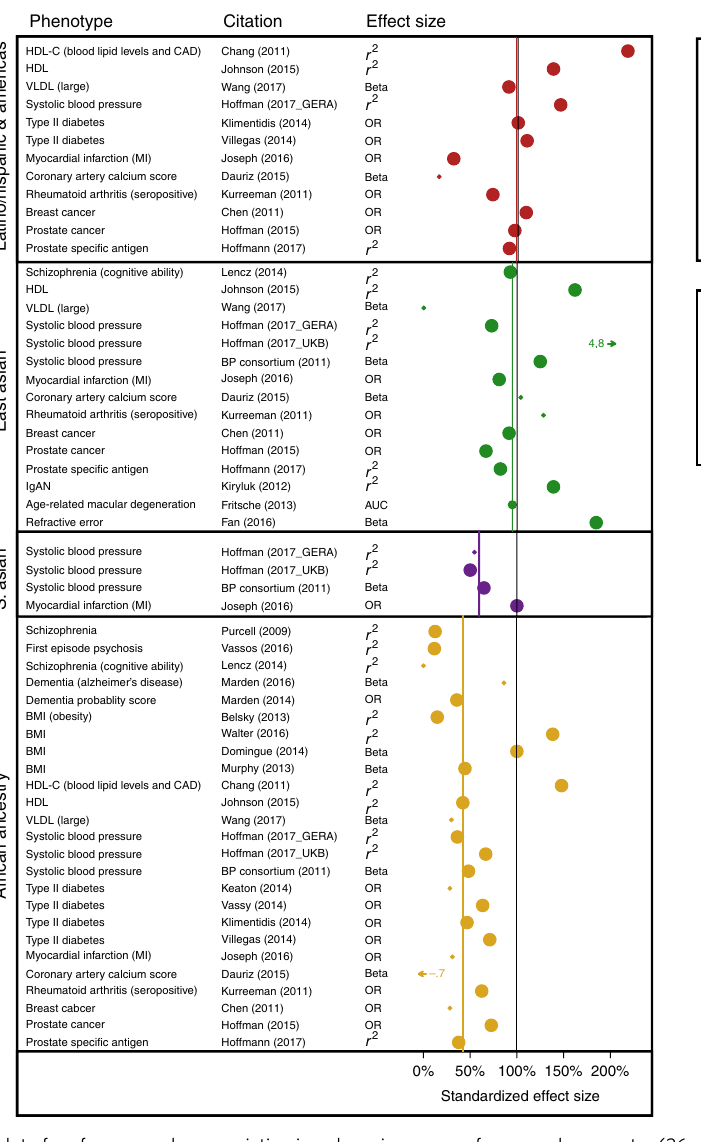
Fig. 2 Forest plot of performance shows variation in polygenic score performance by ancestry (26 studies). Each row in the forest plot (left) represents one pair of polygenic analyses (i.e., in a non-European ancestry sample and a matched European ancestry sample from the same study. Phenotypes, citation information, and available effect sizes are given for each comparison. The vertical black line at 100% corresponds to equal performance in the non- European ancestry and the European ancestry samples. Vertical colored lines denote median standardized effect sizes, for each of the major ancestry groups. On the top right, median values for standardized effect sizes, for each major ancestry group, are given. Standard errors are not provided because many studies lacked suf fi cient information; however, statistical signi fi cance of each non-European ancestry analyses is denoted by point size. HDL-C